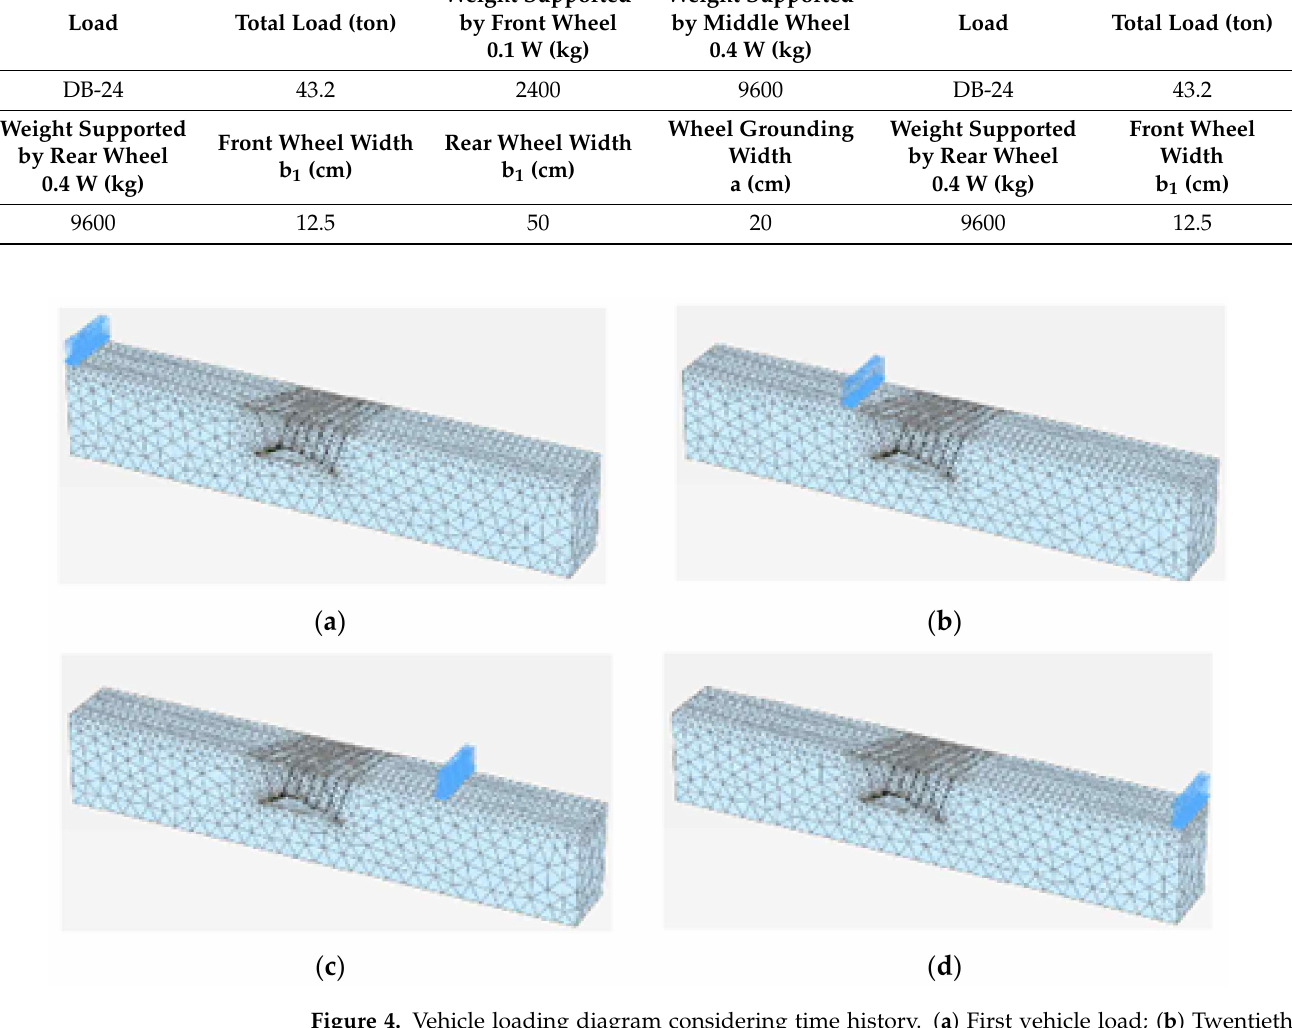
Figure 4. Vehicle loading diagram considering time history. ( a ) First vehicle load; ( b ) Twentieth vehicle load; ( c ) Forty-fifth vehicle load; ( d ) Sixtieth vehicle